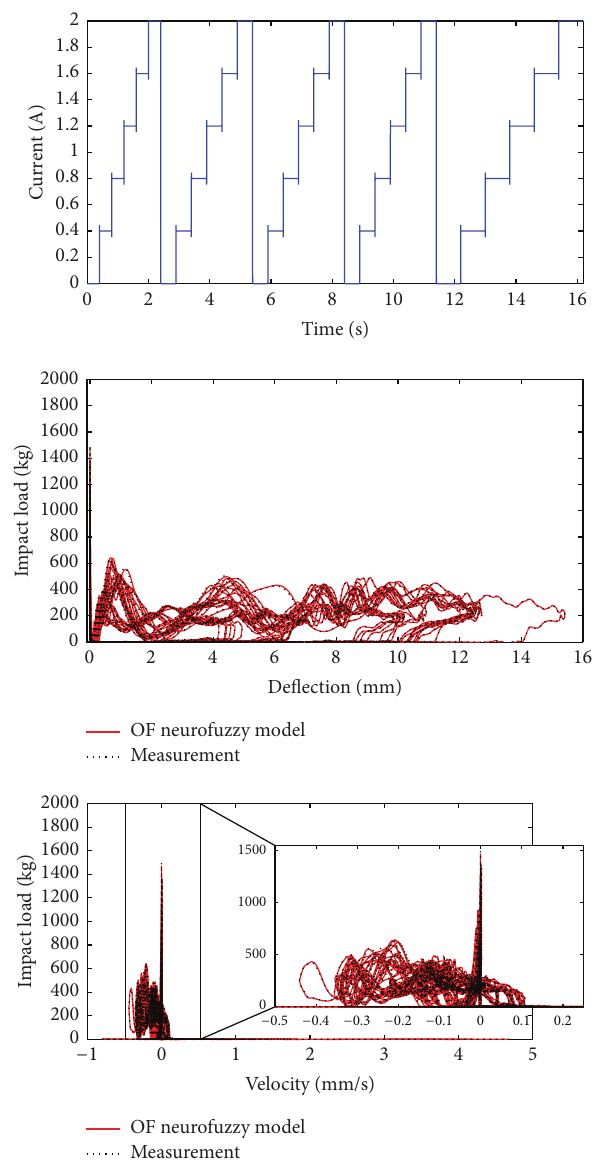
Figure 24: Impact load-displacement and impact load-velocity curves: different drop release heights and constant current